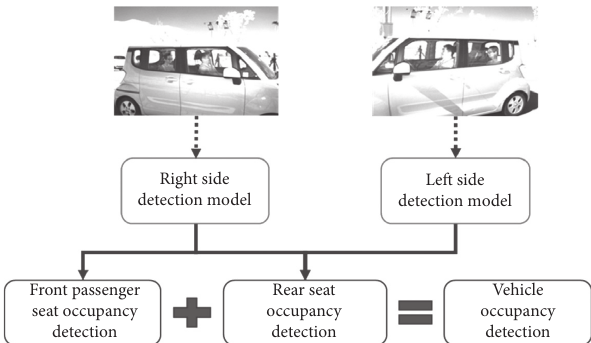
Figure 3: Overview of the vehicle occupancy detection method- ology using both right and left side